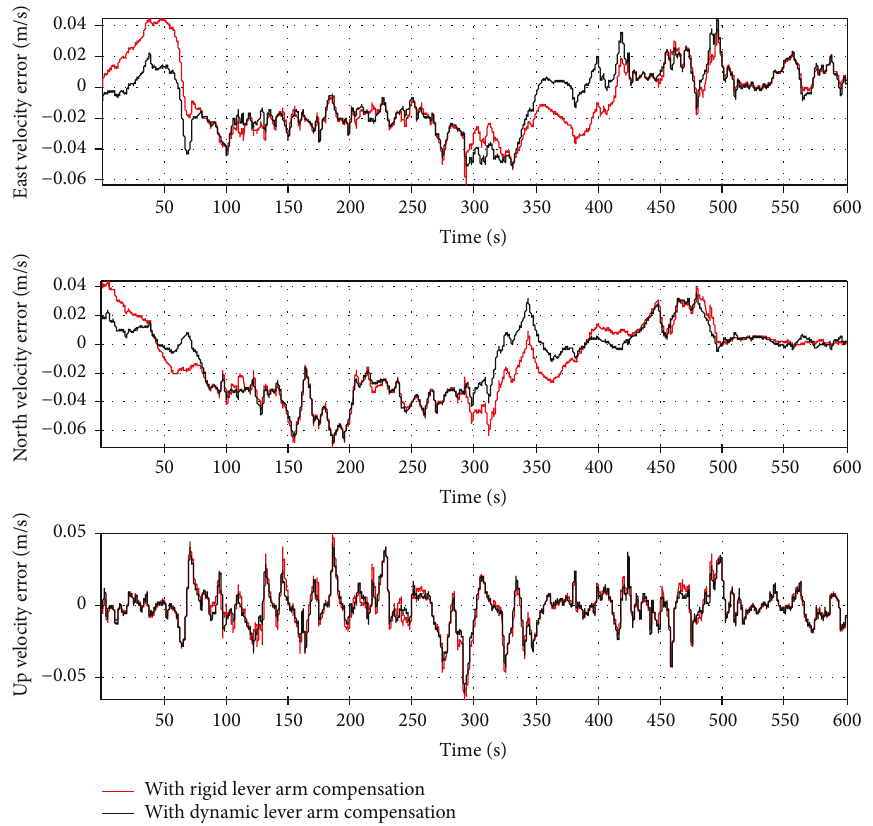
Figure 12: Velocity error comparison of the second-level dynamic lever arm error compensation.